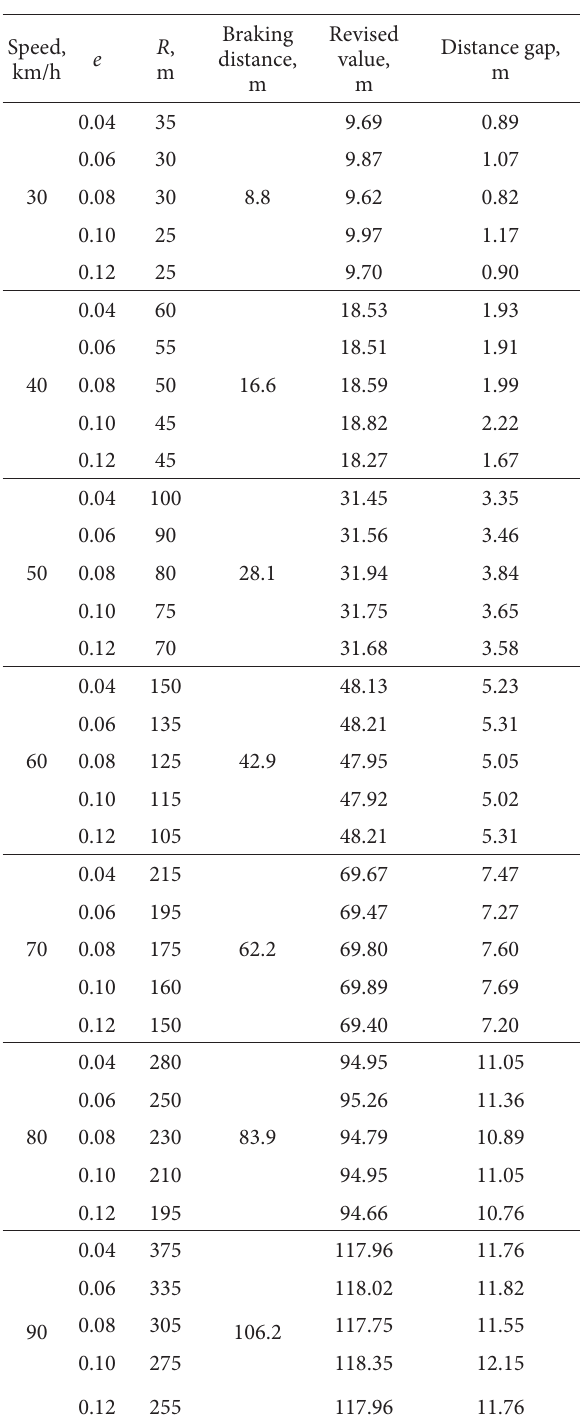
Table 2. Distance gap between the existing braking distance and the revised